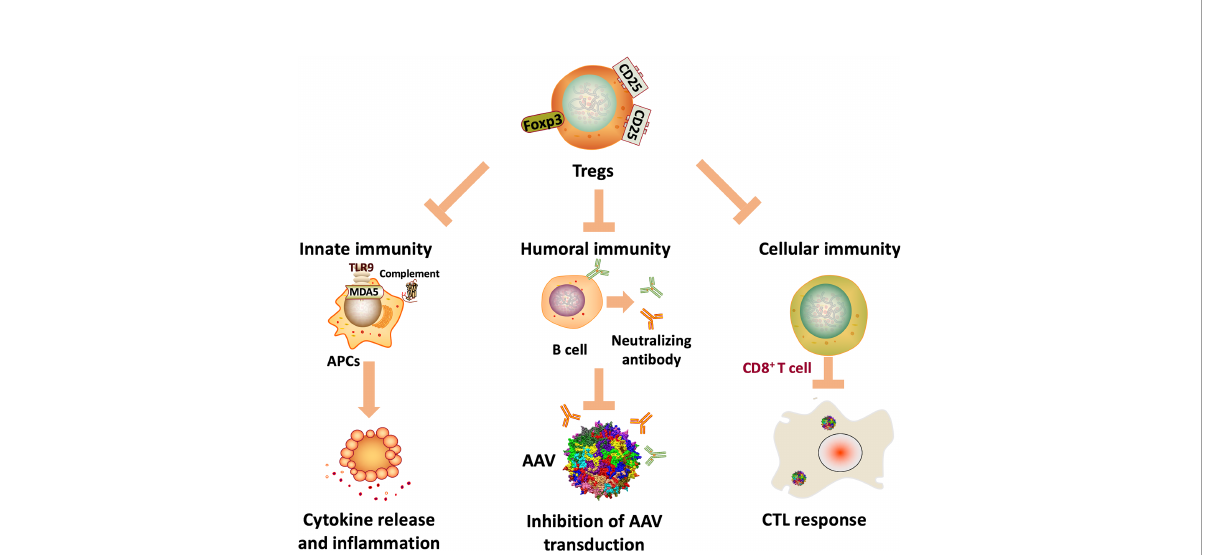
FIGURE 1 Potential mechanisms of AAV immunity. Innate immunity against AAV genome and transcripts can be activated by TLR9 and MDA5 recognition, resulting in cytokine release, in fl ammation, and ultimately CTL responses. In addition, the complement system may also be activated, which is associated with thrombotic microangiopathy and adverse events in clinical trials. Also, humoral immunity against capsids can signi fi cantly inhibit AAV transduction, limiting the application of AAV gene therapy in many patients. Further, cellular immunity against capsids and transgene products can eliminate transgene-expressing cells, ultimately resulting in loss of ef fi